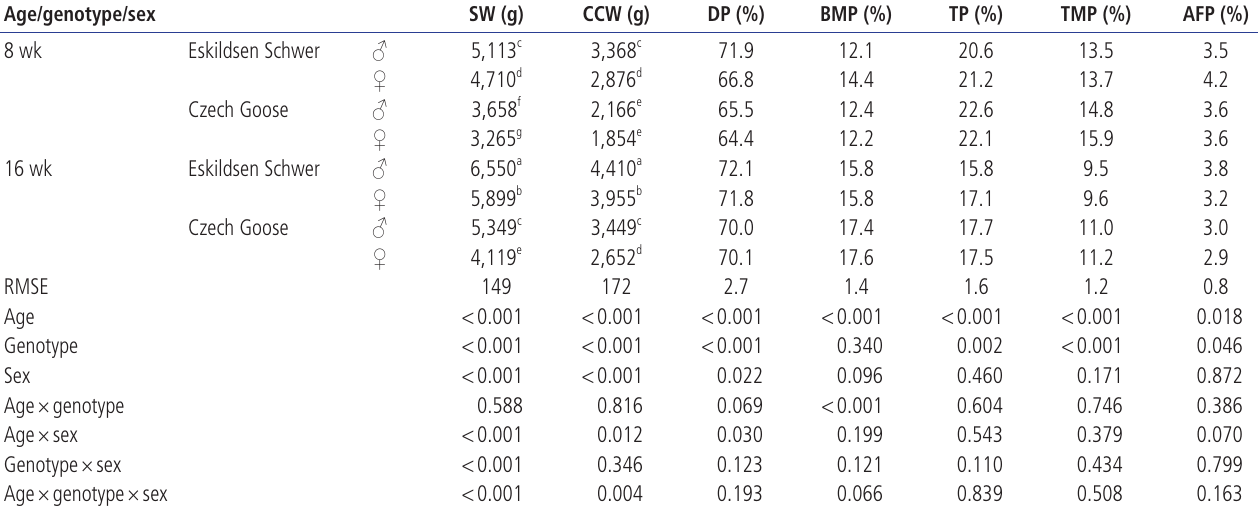
Table 2. Carcass traits in geese as affected by age, genotype and sex Age/genotype/sex